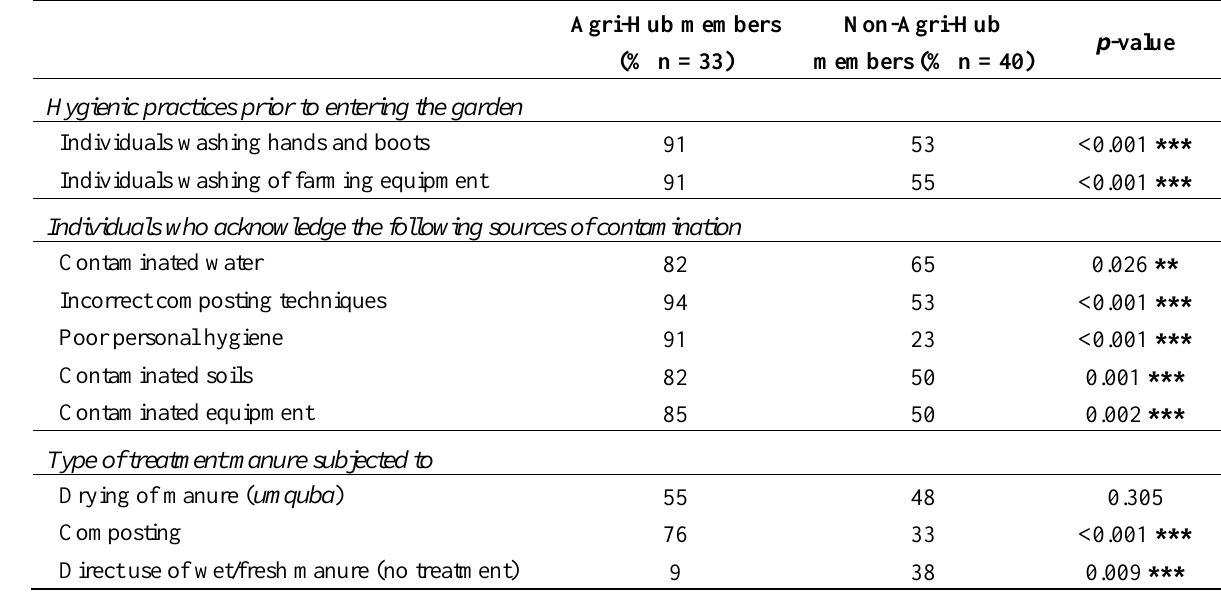
Table 2. Relationships existing between practices and training of small-scale organic farmers.